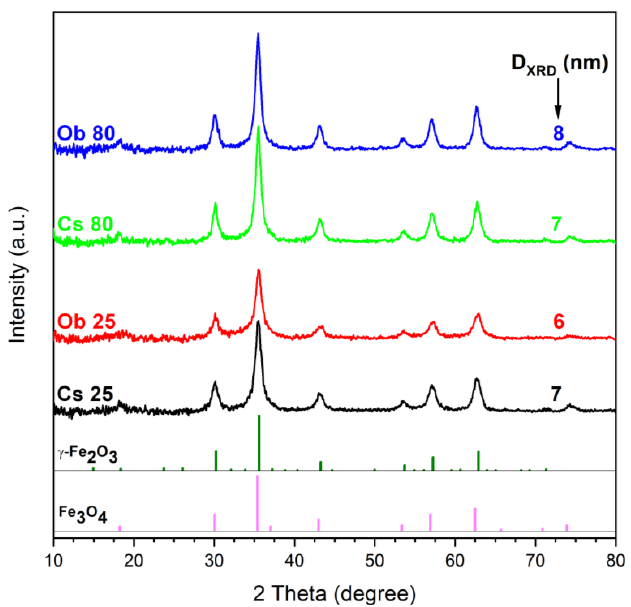
Figure 3. XRD patterns of the MNPs obtained by green synthesis from Cs (green tea) and Ob (basil) ethanolic extracts, at 25 °C and 80 °C.